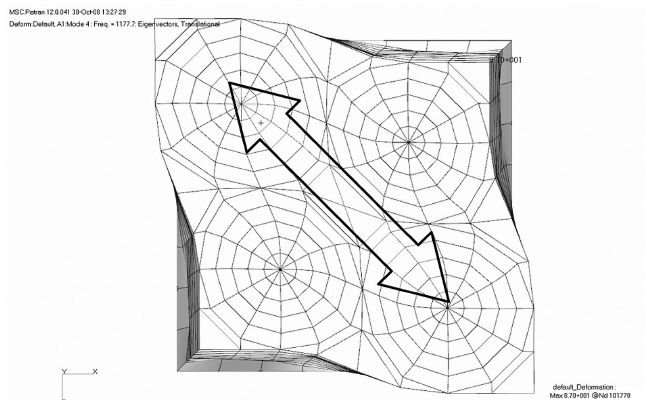
Fig. 17. 4th mode: 1177 Hz – X-Z in-Plane